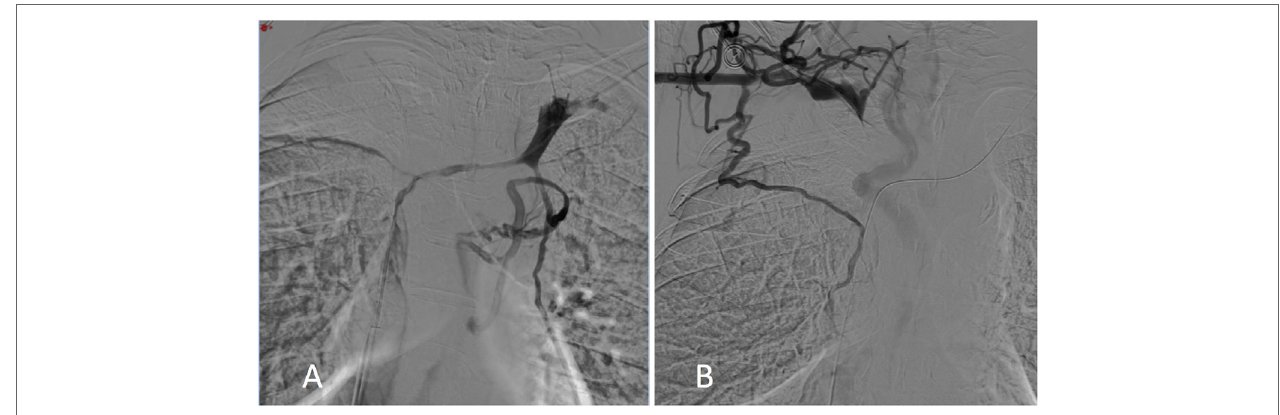
FIgURe 1 | Digital subtraction phlebography from the left (a) and right (B) subclavian veins showed superior vena cava and both the right and left brachiocephalic vein stenosis with collateral